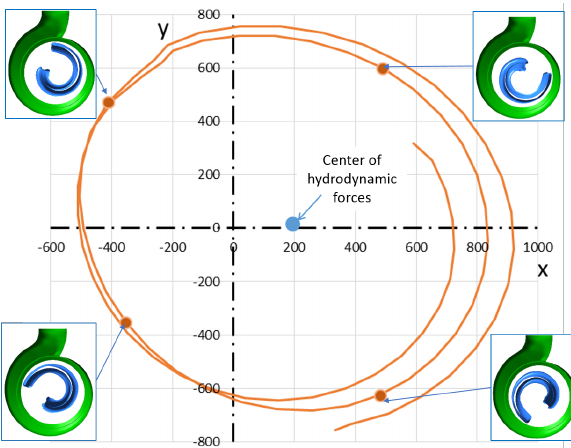
Figure 9: Radial hydrodynamic force,